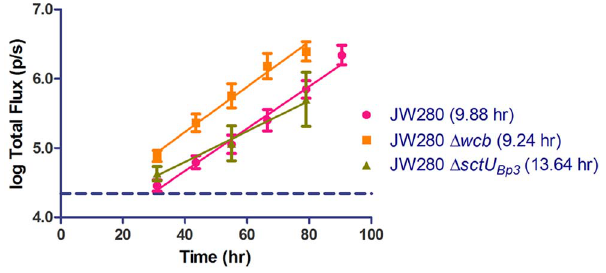
Fig. 8. Detection of pulmonary growth rates of B.pseudomallei mutants in vivo . Groups of 5 female albino C57BL/6J mice were infected with wild type JW280 (10 4.2 CFU), D wcb capsule mutant (10 6.0 CFU), or D sctU Bp3 T3SS3 mutant (10 6.5 CFU), and monitored by optical diagnostic imaging once to twice daily. ROIs from the dorsally- imaged thoracic cavity were plotted as a function of infection time for each mutant. The 95% LOD was calculated for the background luminescence of uninfected mice and indicated as a dotted horizontal line. The calculated doubling rate of bioluminescent signal of each strain is